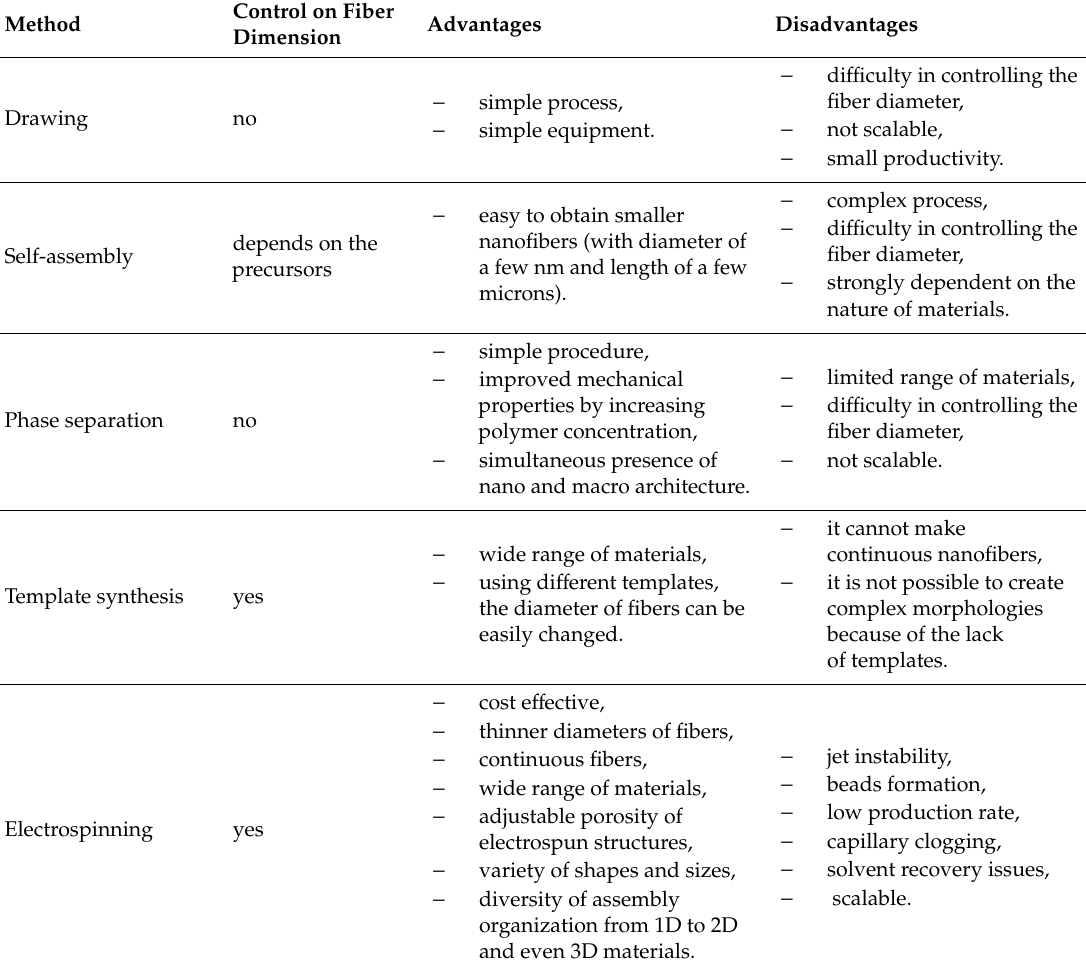
Table 1. Comparison of di ff erent nanofiber fabrication methods